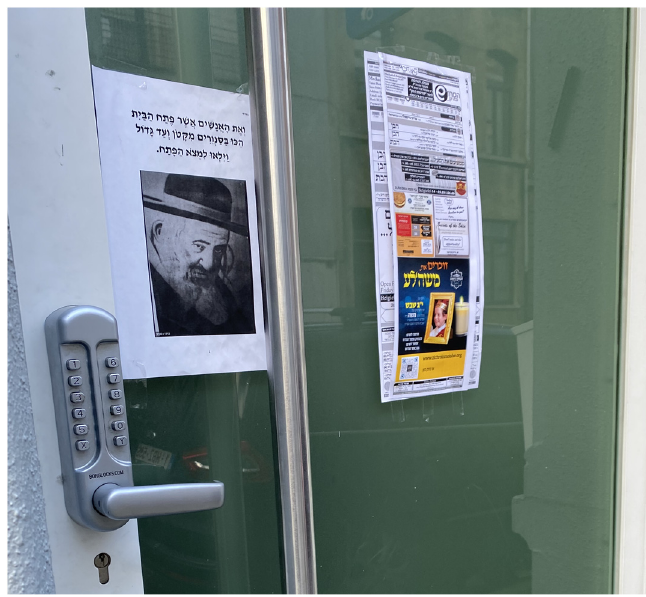
Figure 3. Reb Shayele in Antwerp. An image of Reb Shayele below a biblical verse (Genesis 19:5) on the front of a Hasidic synagogue in Antwerp (Source: photographs by author).